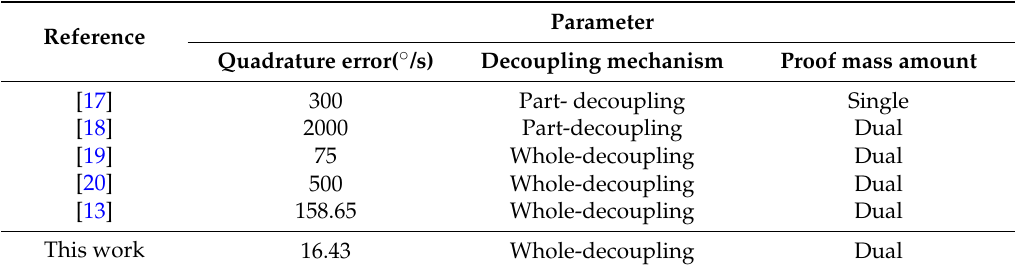
Table 5. Quadrature error comparison with prior